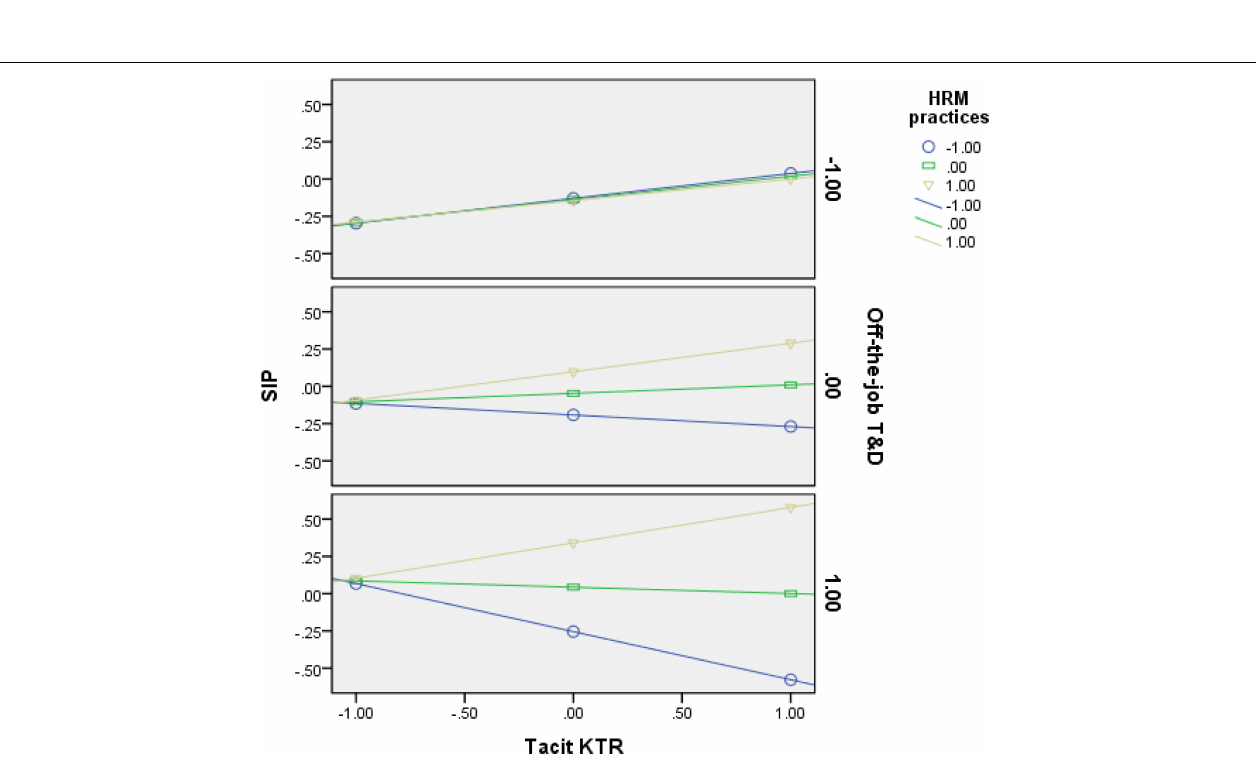
FIGURE 6 | The moderated moderation effects of off-the-job T&D on HRM practices, tacit KTR and SIP.